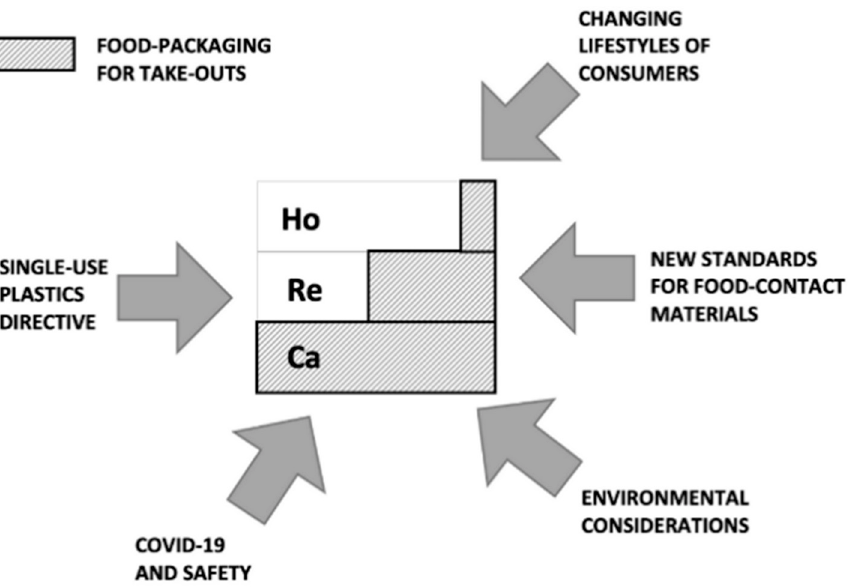
Figure 2. Factors of impact on development of take-away food packaging in COVID-19 period. Source: Authors’.